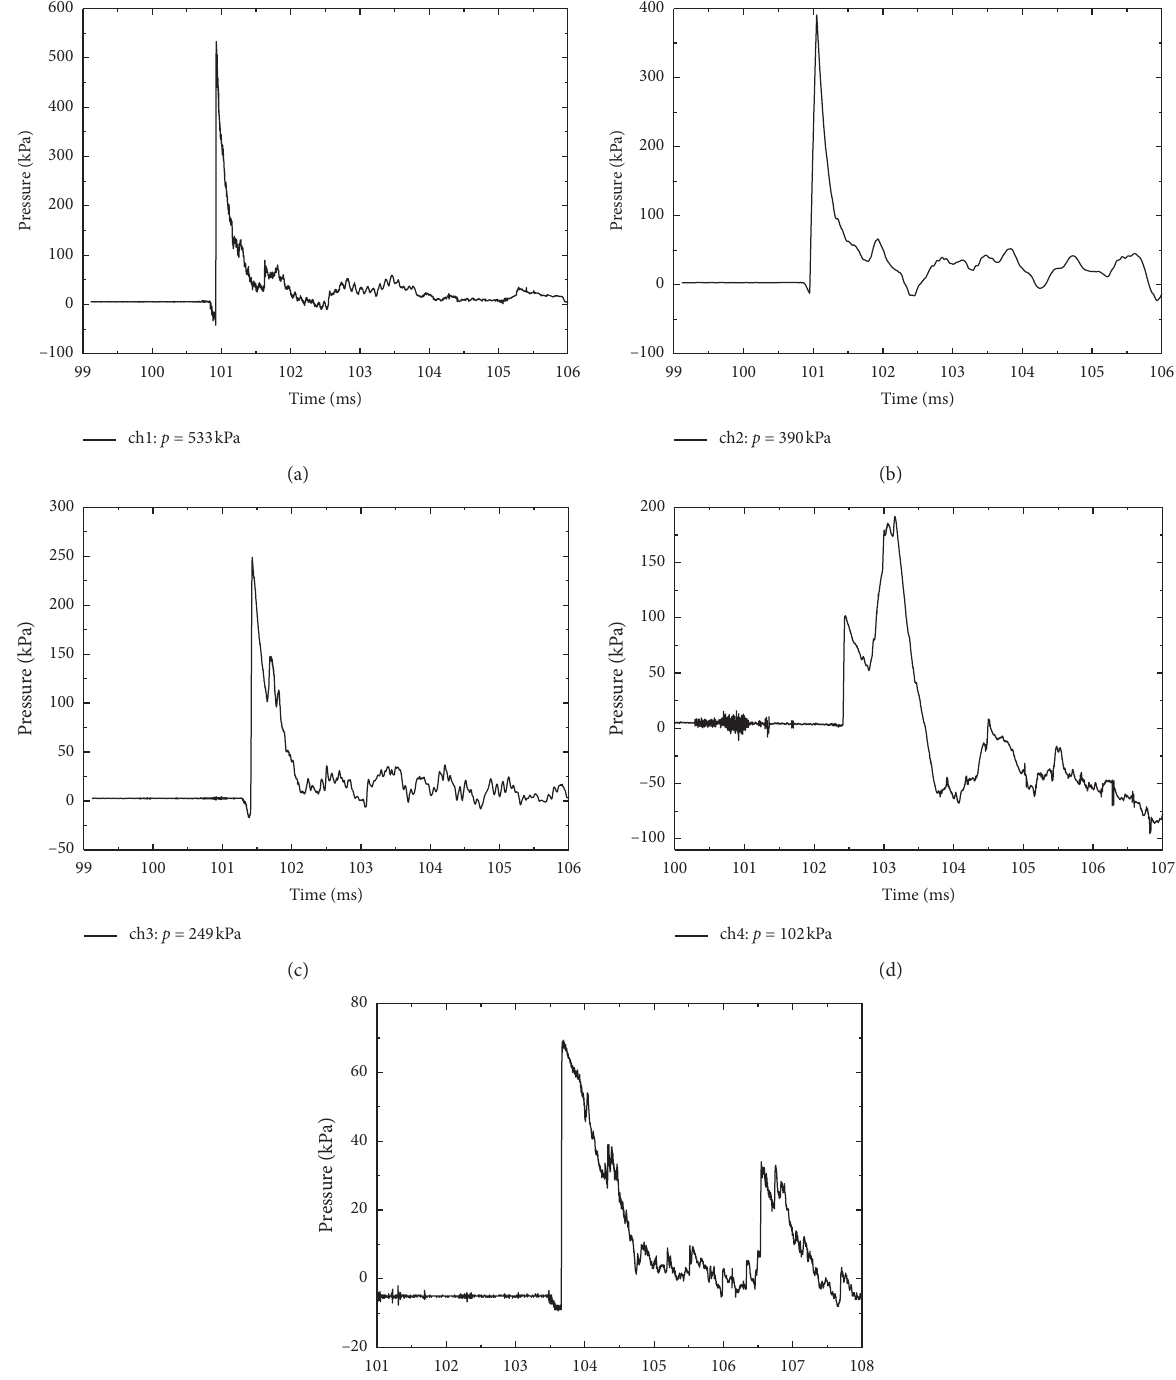
Figure 3: Overpressure-time curve with different locations to explosion center. (a) 1.0 m; (b) 1.2 m; (c) 1.5m; (d) 2.0m; (e)